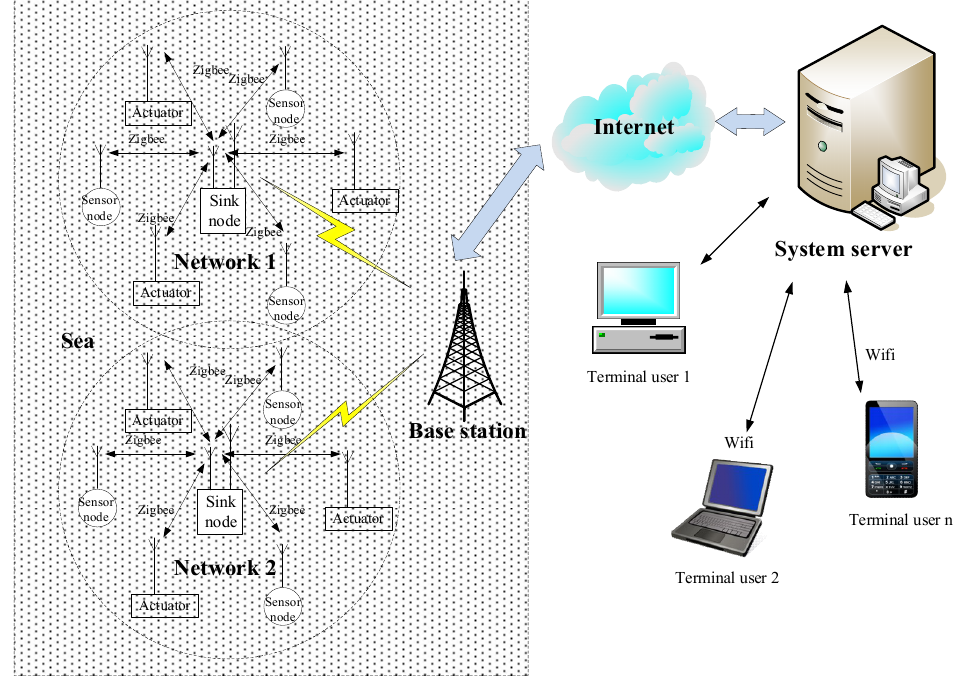
Figure 2. Common physical architecture of IoT-based marine environment monitoring and protection systems.